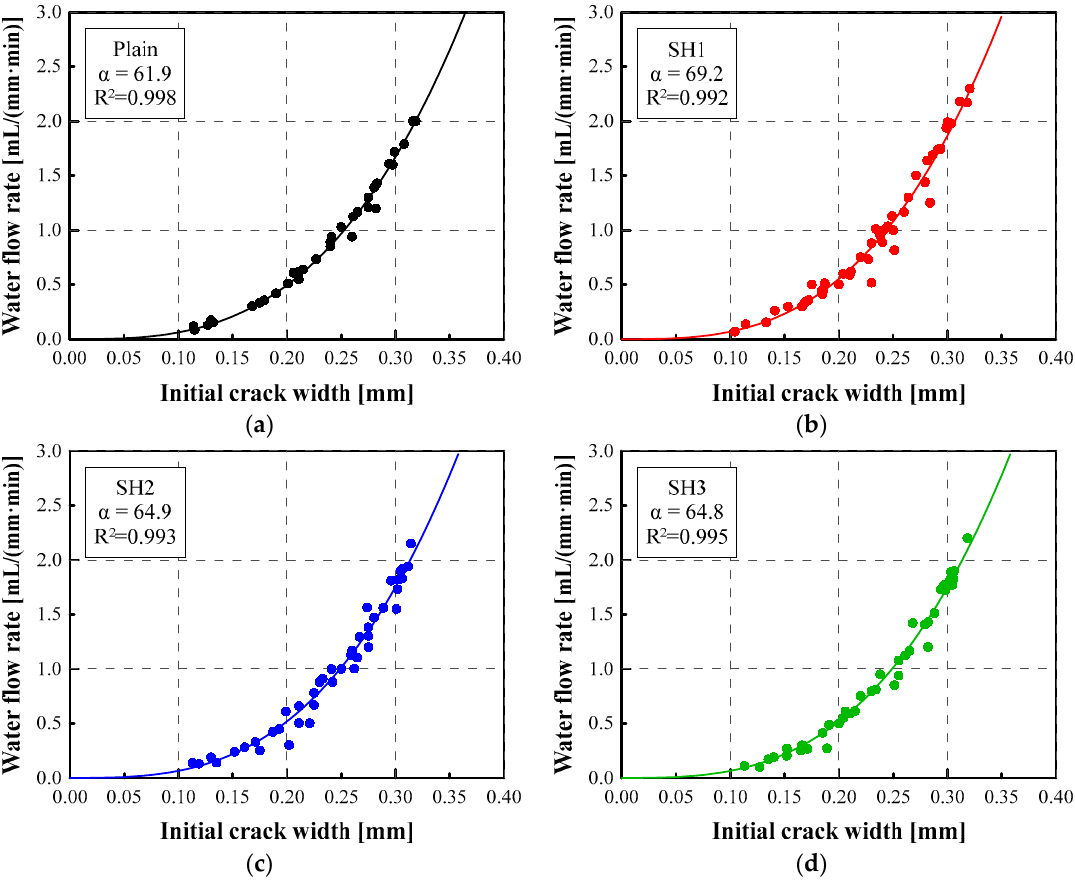
Figure 5. Relationship of crack width and water flow rate: ( a ) Plain, ( b ) SH1, ( c ) SH2, ( d ) SH3. According to Poiseuille’s law, the reduction factor ( ξ ) in Equation (1) should be 1.0 for an ideal crack. However, due to the roughness and tortuosity of the cracks, the proportional coefficients measured are in the range of 61.9~69.2 mL/(mm · min). This corresponds to a ξ of 0.21~0.24. This range is similar to the values of 0.22~0.25 for mortar mixtures with W/C = 0.48 and S/C = 0.8 [27] and also similar to the value of 0.25 from the experimental results obtained with concrete mixtures [16].